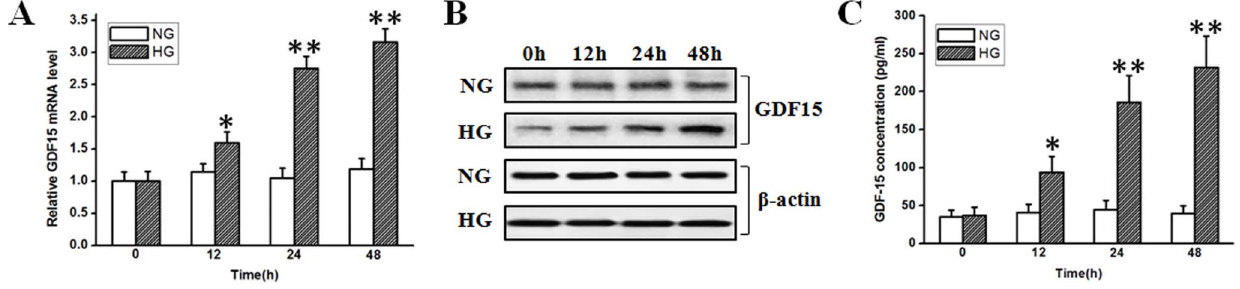
Figure 1. Adaptive induction of GDF15 in HUVEC cells in response to high glucose stimulus. HUVEC cells were treated with normal (5.5 mmol/l) or high (33.3 mmol/l) glucose. At indicated time points, GDF15 expression and secretion were detected by RT-PCR, western blot, and ELISA. A, analysis of GDF15 mRNA expression with RT-PCR. B, western blots of GDF15 and b -actin. C, ELISA assay of secreted GDF15. NG, normal glucose. HG, high glucose. *, P , 0.05, **, P , 0.01 versus